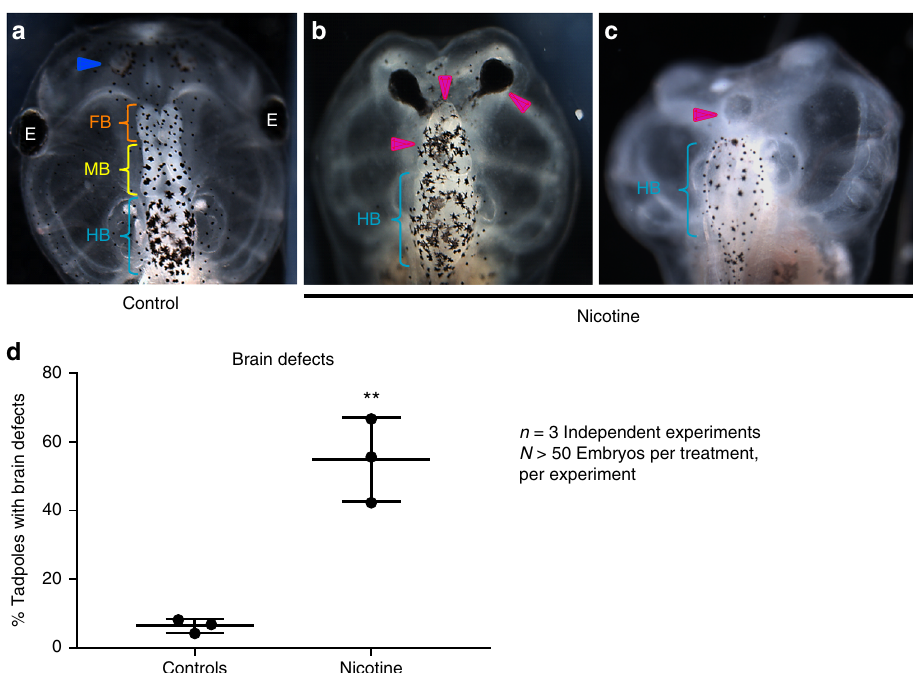
Fig. 1 Nicotine induces brain morphology defects in Xenopus embryos. Representative images of stage 45 tadpoles: a control tadpole showing nostrils (blue arrowhead), forebrain (FB) indicated by the orange bracket, midbrain (MB) indicated by the yellow bracket, and hind brain (HB) indicated by the cyan bracket, b and c tadpoles from embryos exposed to nicotine (0.1 mg/mL – stage 10 – 35) showing severe brain morphology defects as indicated by magenta arrowheads. Cyan brackets indicate presence of hindbrain (HB). d Quanti fi cation of stage 45 tadpoles for major brain morphology phenotypes in absence or presence of nicotine exposure (0.1 mg/mL – stage 10 – 35). A signi fi cantly high incidence of malformed brain was observed in embryos exposed to nicotine in comparison to controls. Three independent experiments ( n = 3) were conducted with N > 50 embryos per treatment group for each of those experiments collected from multiple animals across independent clutches. Data were analyzed with t-test and graphed as mean ± SD; ** p <